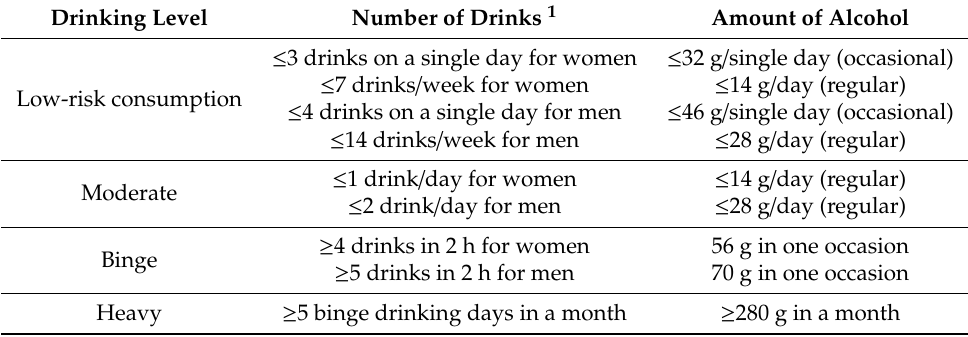
Table 1. Definition of drinking levels according to the US National Institute on Alcohol Abuse and